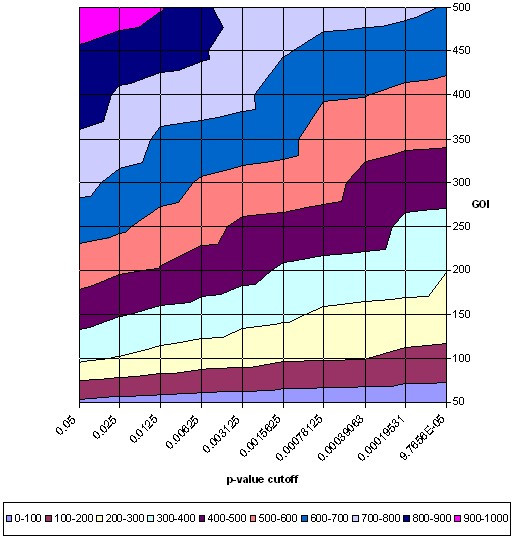
Overhead view of surface topology for the Meiklejohn data set. Different shadings represent different numbers of significant terms.